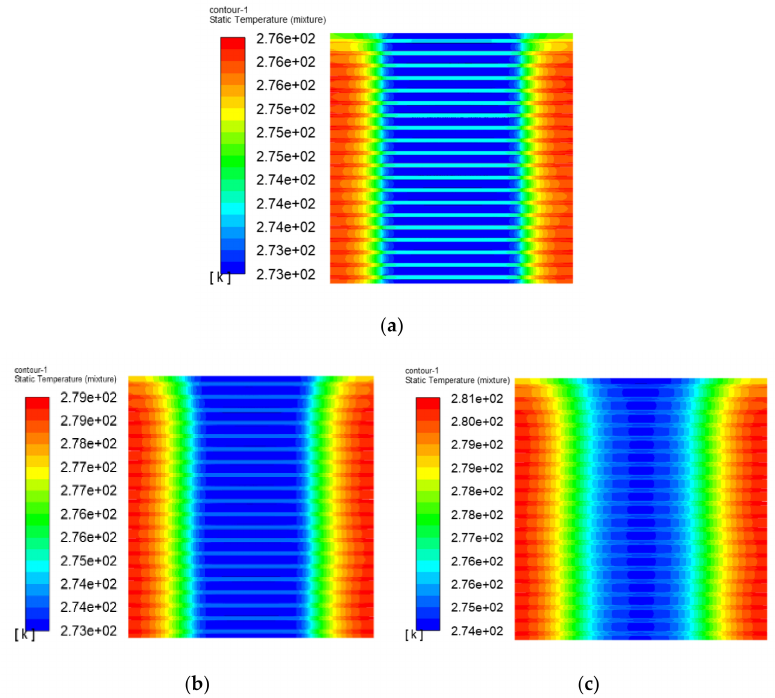
Figure 16. Temperature contours of the PEMFC stack at di ff erent times; ( a ) t = 24 s, ( b ) t = 32 s, ( c ) t = 36